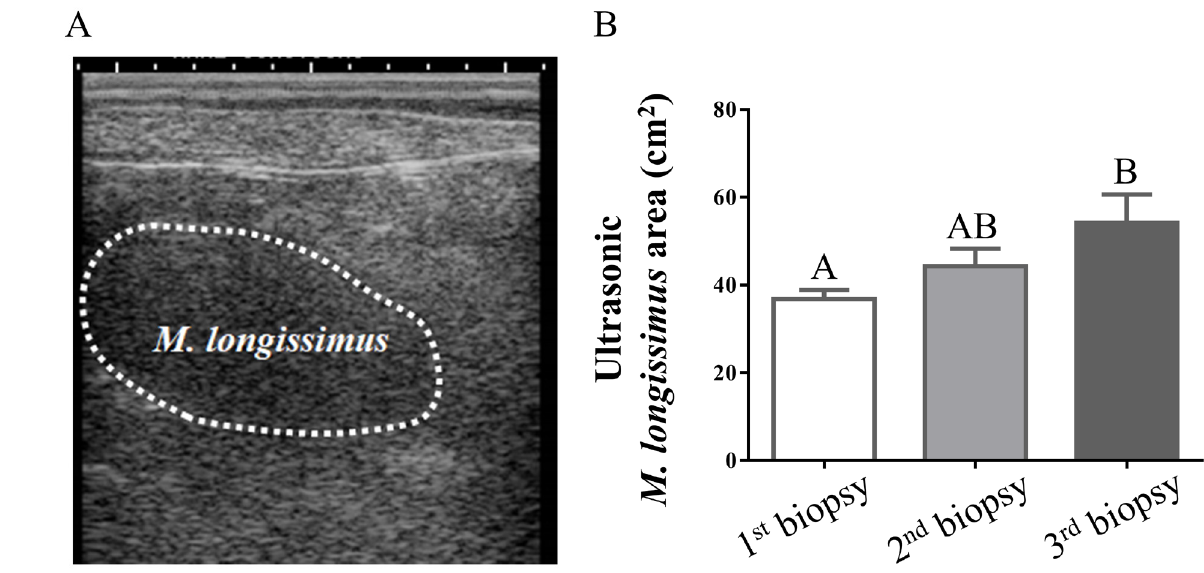
Figure 1. Effects of the fattening stage on ultrasonic M. longissimus area in Japanese Black cattle. (A) A typical photo image of M. longissimus in ultrasonic scanning. (B) Differences among groups were compared using a one-way analysis of variance (factor: time at biopsy) followed by the Tukey’s multiple comparison test. The data are expressed as means±standard error of the mean. n = 6 for each time point. Groups with different letters are significantly different